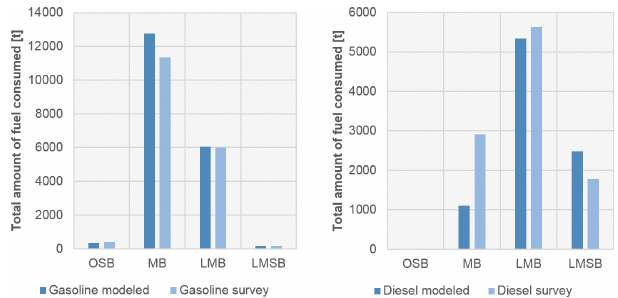
Figure B1. Comparison of fuel consumption statistics for the Swedish fleet in the Baltic Sea against BEAM model predictions. Comparison has been made for each class and separately for gaso- line and diesel